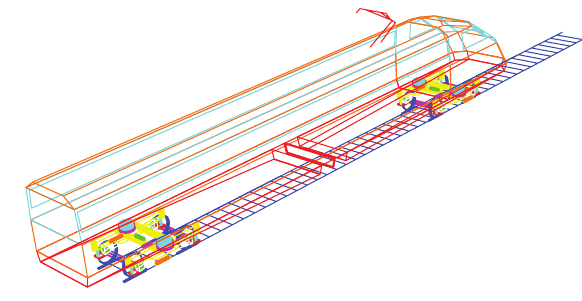
Fig. 6. The vehicle dynamics